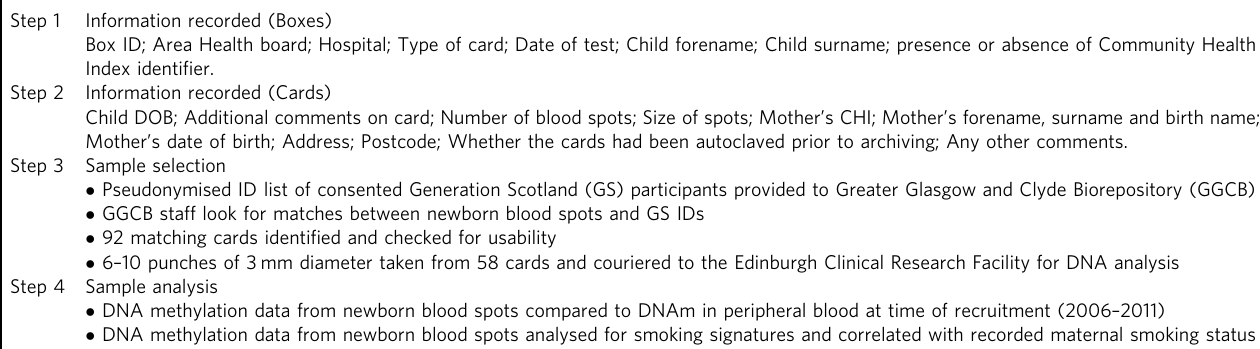
Table 3 Newborn blood spot archive examination and sample selection for